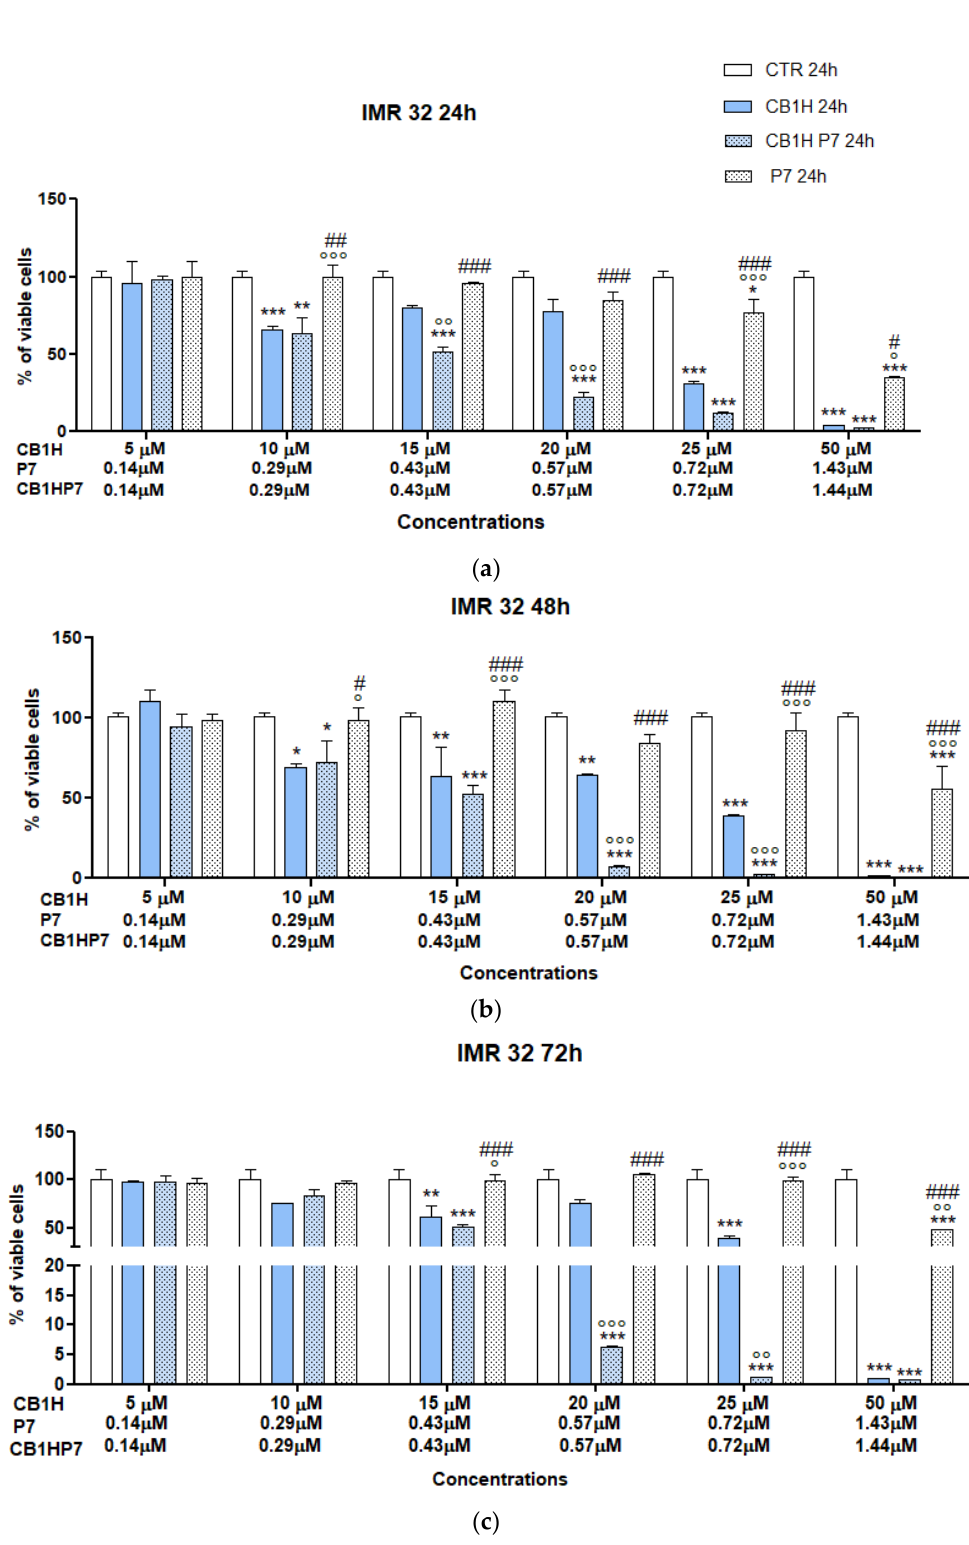
Figure 1. Dose- and time-dependent cytotoxicity activity of CB1H, P7 and CB1H-P7 NPs at 24 h ( a ), 48 h ( b ), and 72 h ( c ) towards IMR 32 cells. Significance refers to control (*), CB1H (°), or CB1H-P7 (#). Specifically, p > 0.05 ns; p < 0.05 * (vs. CTR), ° (vs. CB1H), # (vs. CB1H-P7); p < 0.01 ** (vs. CTR), °° (vs. CB1H), ## (vs. CB1H-P7); p < 0.001 *** (vs. CTR), °°° (vs. CB1H), ### (vs. CB1H-P7).